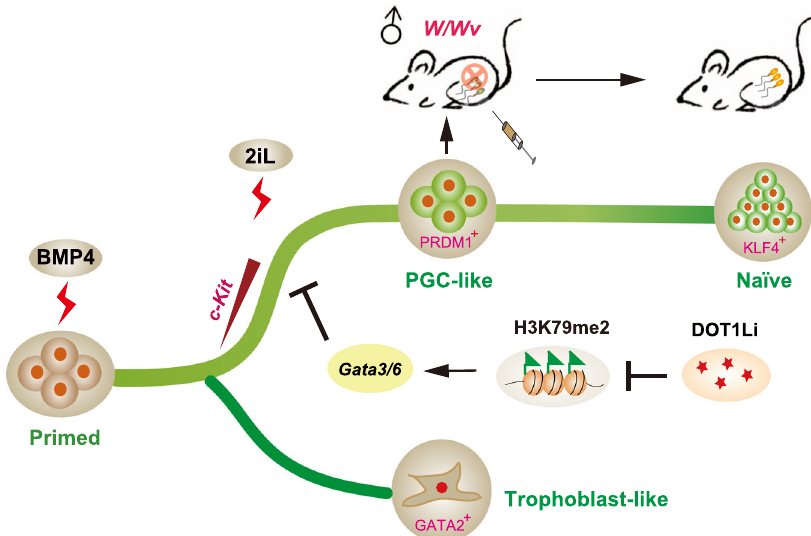
Fig. 8 Schematic diagram of cell fate trajectories during BiPNT. During BiPNT, EpiSCs bifurcate into c-Kit + naïve and c-Kit - trophoblast-like cells. A PGC- like intermediate which capable of spermatogenesis in vivo is emerged before reaching to the naïve pluripotent state. The inhibition of DOT1L activity permits the transition from primed pluripotency to PGCLCs in part by facilitating the loss of H3K79me2 from Gata3 / 6 and repressing their